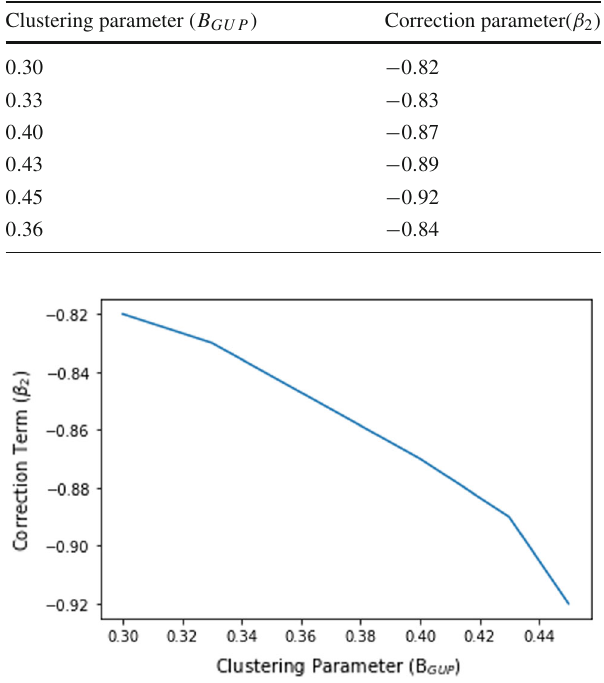
Fig. 5 The variation of correction term β 2 with clustering parameter B